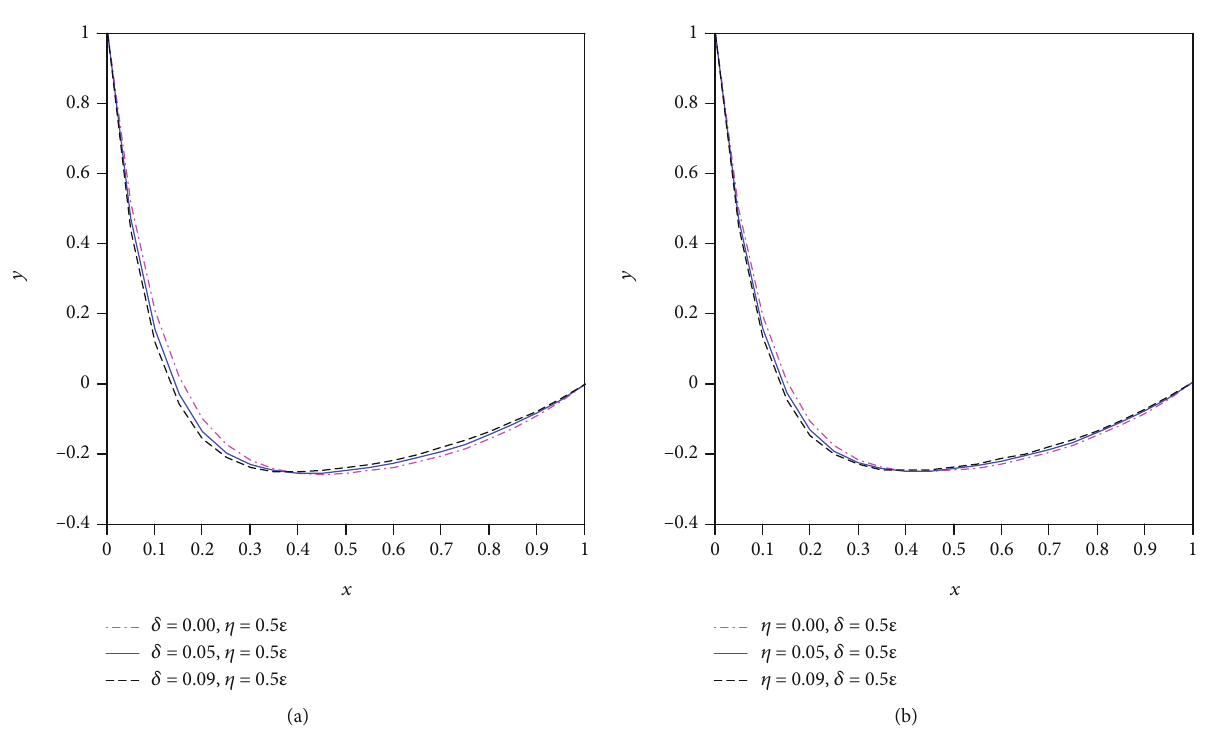
Figure 2: Numerical solution of Example 6 for ε = 0 : 1 and N = 20